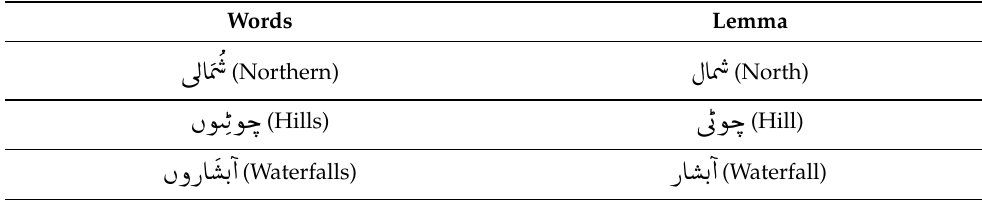
Table 6. Example of lemmatized diacritized Urdu